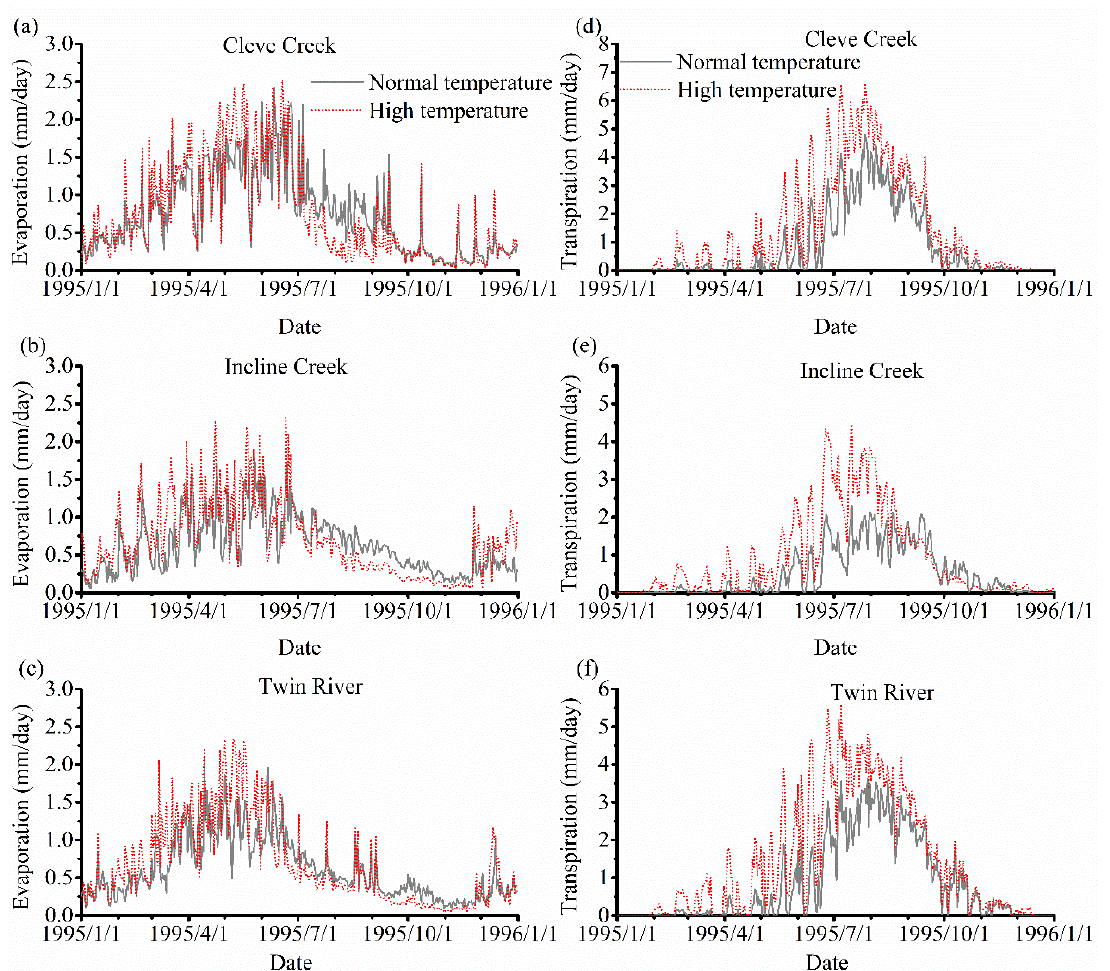
Figure 11. Comparison of evaporation and transpiration under the two different temperature scenarios without vegetation in 1995. The evaporation of Cleve Creek, Incline Creek, and Twin River watersheds are shown in ( a – c ), respectively. The transpiration of Cleve Creek, Incline Creek, and Twin River watersheds are shown in ( d – f ), individually.